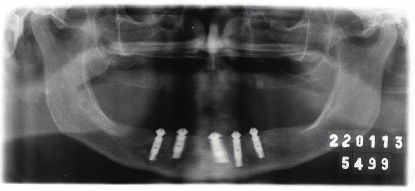
Figure 16: Radiographic control at 2-year